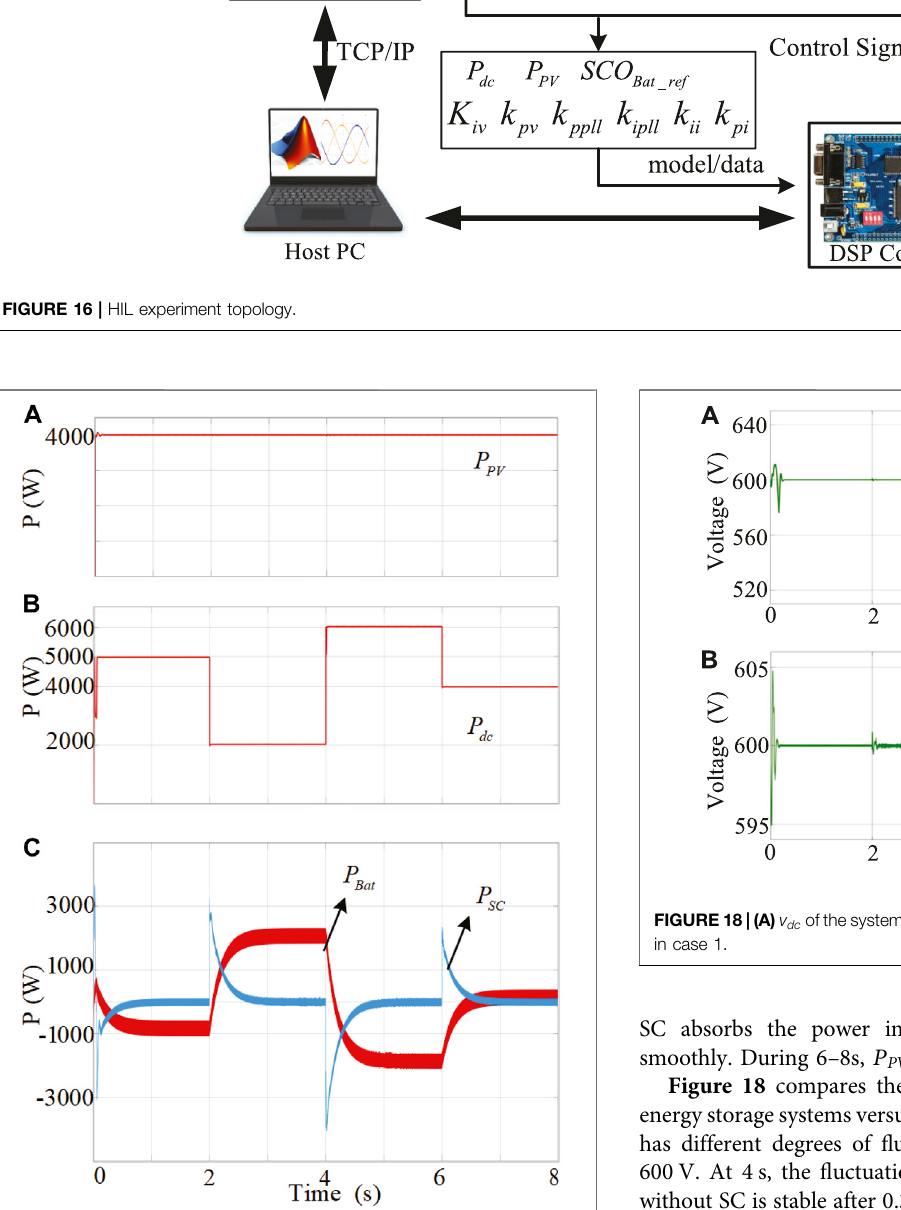
FIGURE 17 | (A) DC bus output power P dc ; (B) PV array output power P PV ; (C) HESS output power.